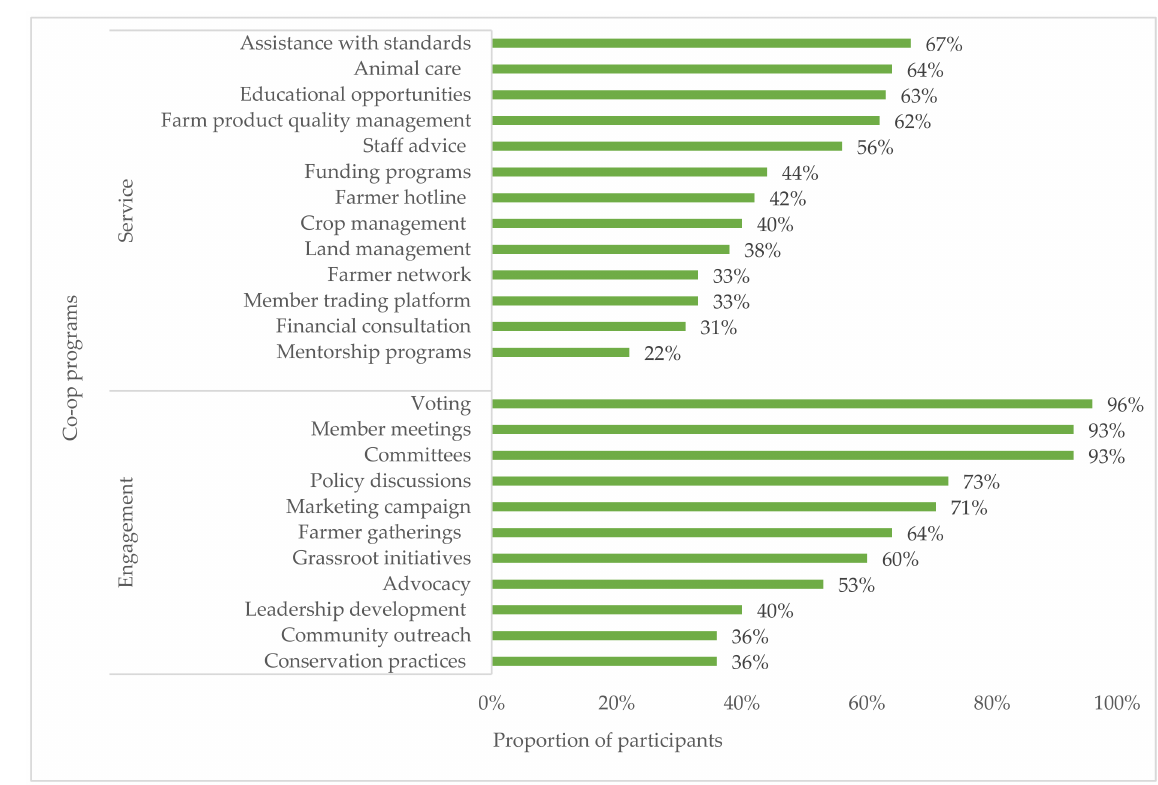
Figure 4. The availability of co-op service and engagement programs during the last 12